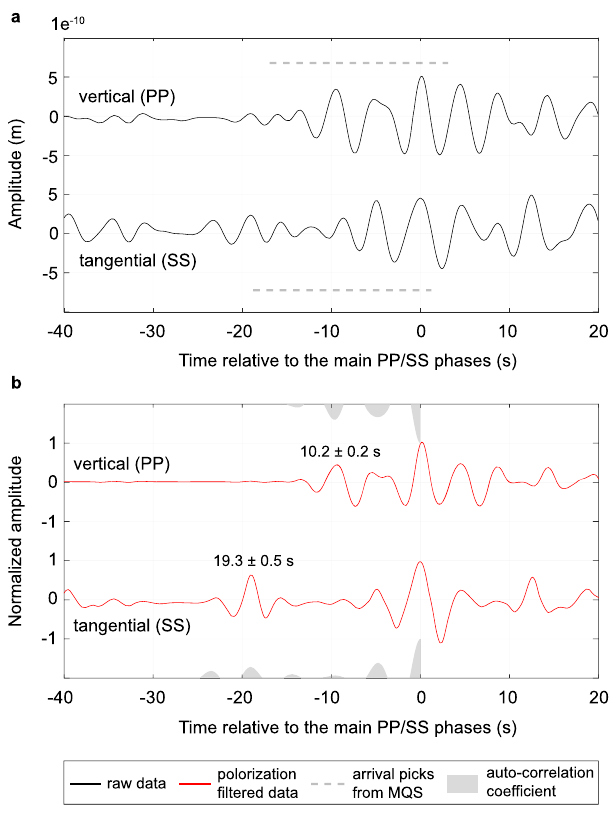
Fig. 2 | InSight seismic observations of the PP and SS waves. a The top and bottomtracesarethedisplacementwaveformsontheverticalcomponentnearthe arrival of the PP phase and the tangential component near the arrival of the SS phase, respectively. Both traces are bandpass fi ltered between 2.8s and 6s with a two-pass second-order Butterworth fi lter. The signals at 0s are the preferred PP andSSphasespickedinthisstudy,andthedashedgreybarsindicatethePPandSS arrivals (with an uncertainty of 10s) provided by Horleston et al. (2022) (ref. 7). b Similar to ( a ) but with an additional polarization fi ltering 27 to enhance the body- wave signals. The differential arrivals of the PP/SS precursors are also annotated (see Methods section for the uncertainty estimations). The positive parts of the auto-correlation coef fi cients forthe verticaland tangentialcomponentsare shown as shaded waveforms on the top (multiplied by − 1 to fi t into the plot) and bottom axes, respectively.